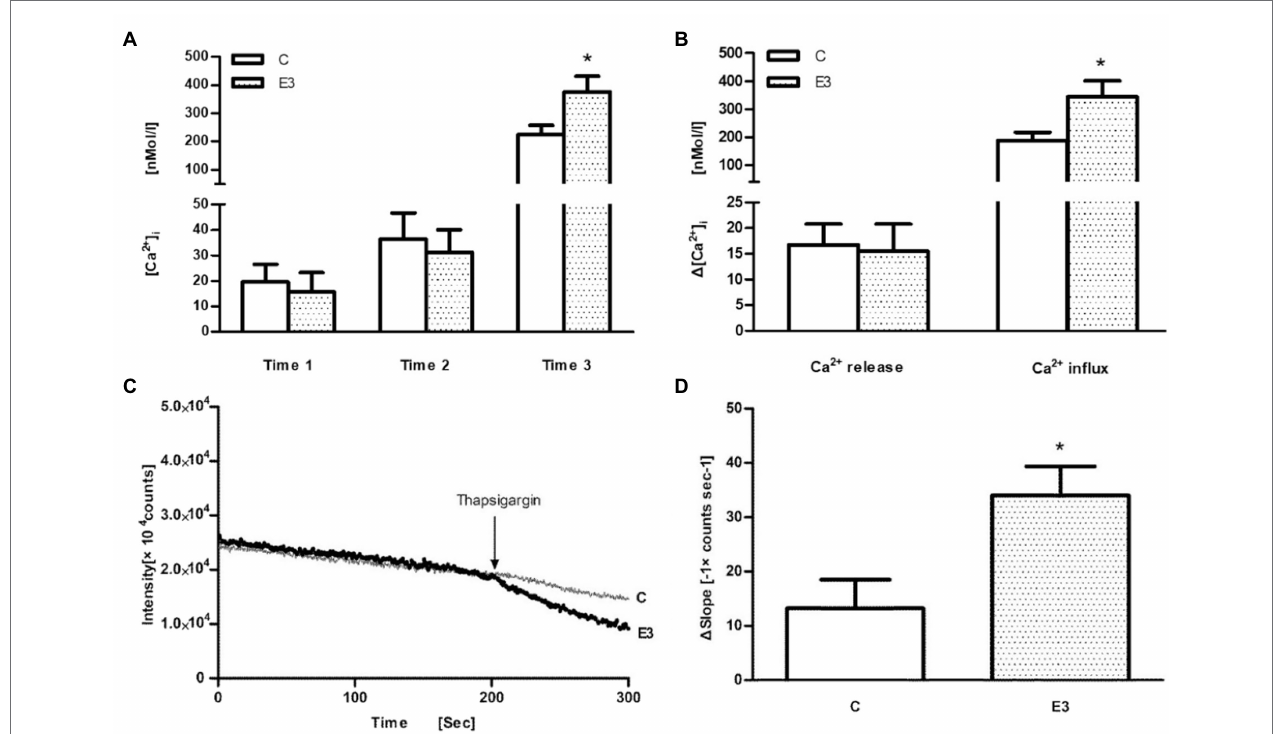
FIGURE 4 | The effect of acute exercise on TG-induced change of [Ca 2+ ] i and Mn 2+ influx in murine splenic lymphocytes. C: the control group; E3: the exercise group with cell isolation 3 h after exercise. (A) Measurement of [Ca 2+ ] i initially under Ca 2+ -free buffer (=time 1), application of TG (=time 2), and addition of CaCl 2 (=time 3); (B) Ca 2+ release was quantified by the differences of levels between time 2 and time 1, whereas Ca 2+ influx was quantified by the differences of levels between time 3 and time 2. (C) Representative tracings of the manganese influx measurements of the E3 group (heavy dotted line) and C group (light continuous line). (D) The bar chart diagrams show that transmembrane Mn 2+ influx into cells after the addition of TG was statistically elevated in E3. Data are presented as means ± SEM ( n = 5). * p < 0.05 vs. control ( n =